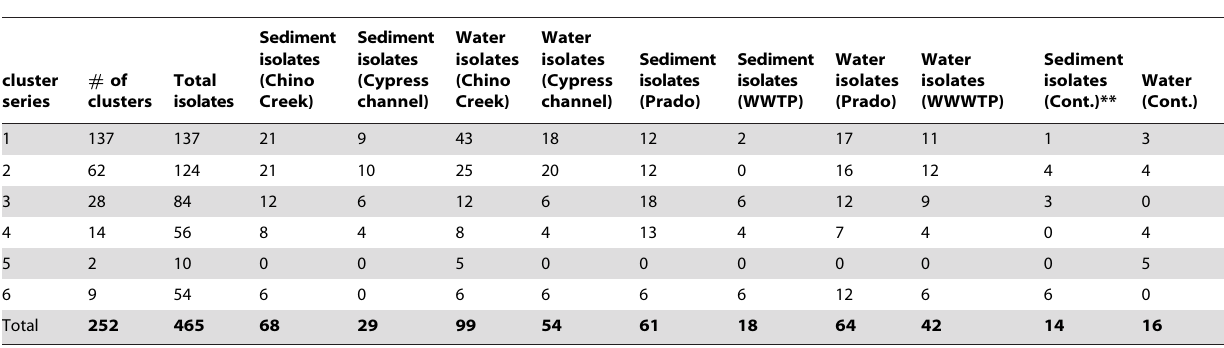
Table 3. Genotypic diversity of E. coli isolates from the Middle Santa Ana River watershed derived from major sources by PFGE.*